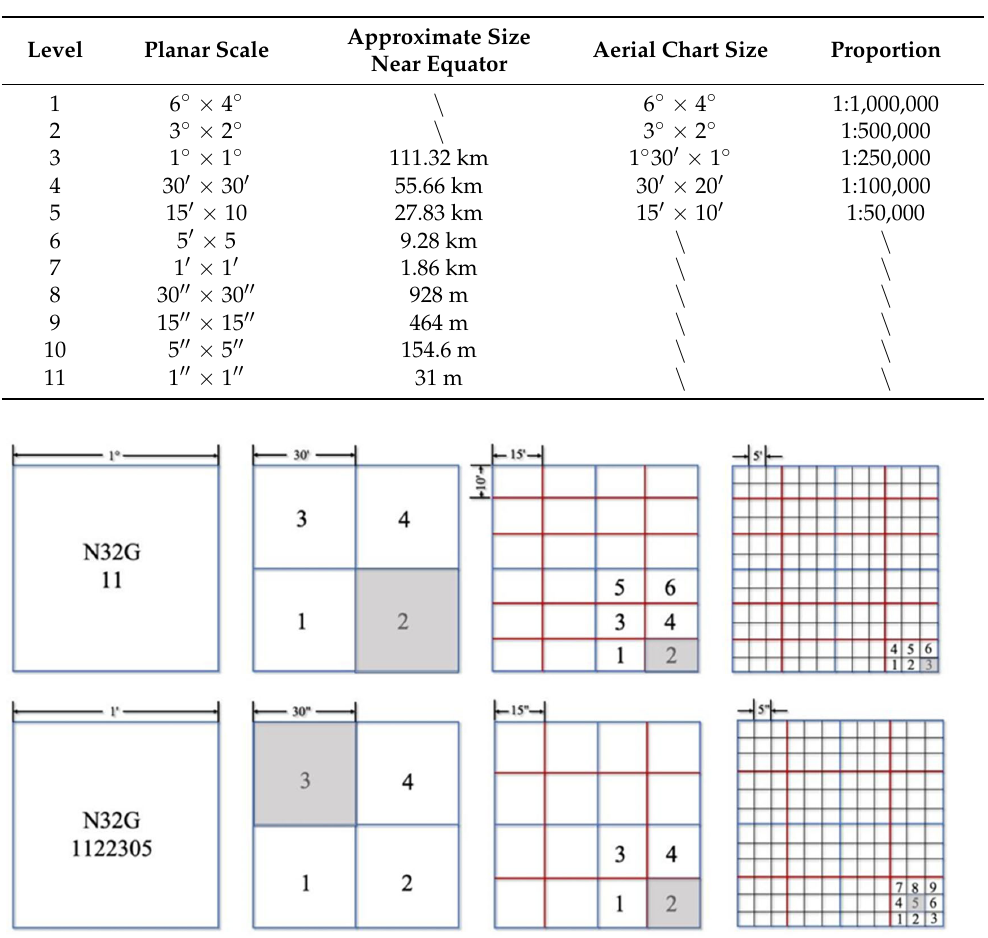
Table 1. GeoSOT ‐ AS planar dimensional dissection scales corresponding to multi ‐ level charts.